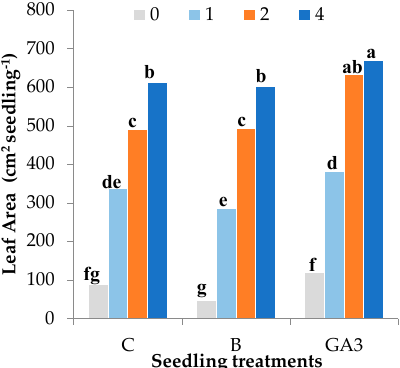
Figure 7. Effect of the seedling treatments (C, untreated control, B, bacterial biostimulant, GA3, gibberellic acid spray 10 − 5 M) and the nursery fertigation rates (g L − 1 of NPK 20 ‐ 20 ‐ 20) on the leaf area of Solanum lycopersicum ‘Marmande’ seedlings (bars with different letters are significantly different at p < 0.05 according to the LSD test). The specific leaf area (SLA) is an index of leaf morphology (thickness) and dry biomass distribution in the leaves (Table 2). This parameter showed a slight but not significant increase in the treated seedlings against the control seedlings. The effect of fertilizer concentration on SLA was more evident and followed a quadratic trend (R 2 = 0.9256***) raising from 301.1 cm 2 g − 1 DW (0 g L − 1 ) up to 681.0 cm 2 g − 1 DW (2 g L − 1 ).